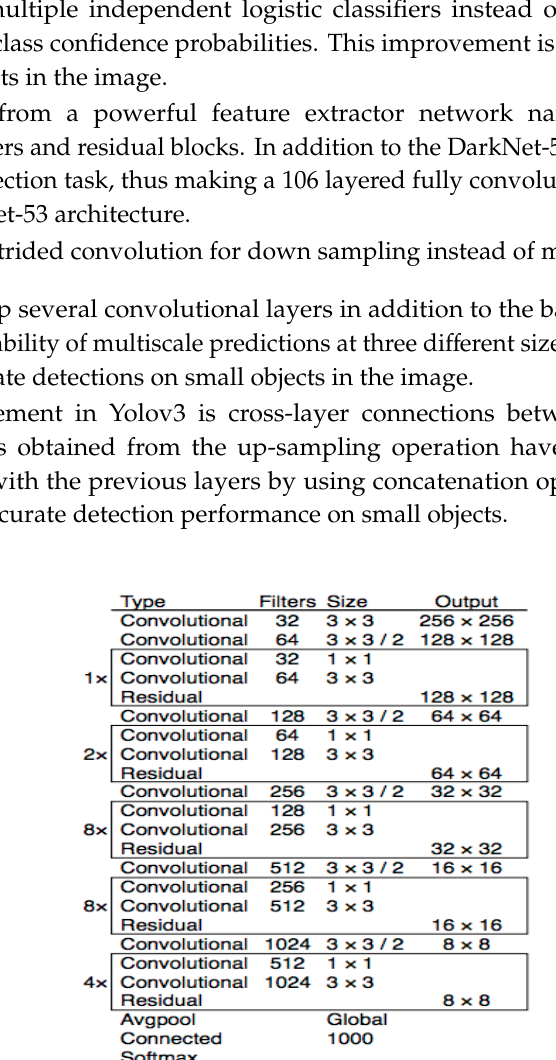
Figure 8. The yellow frame is a bounding box created by the red grid that is responsible for the detection of the lesion. It creates a certain number of bounding boxes. Every bounding box has such parameters as x and y, central coordinates, of the bounding box, w and h, width and height of the bounding box, p o confidence score and p cn class probability scores.